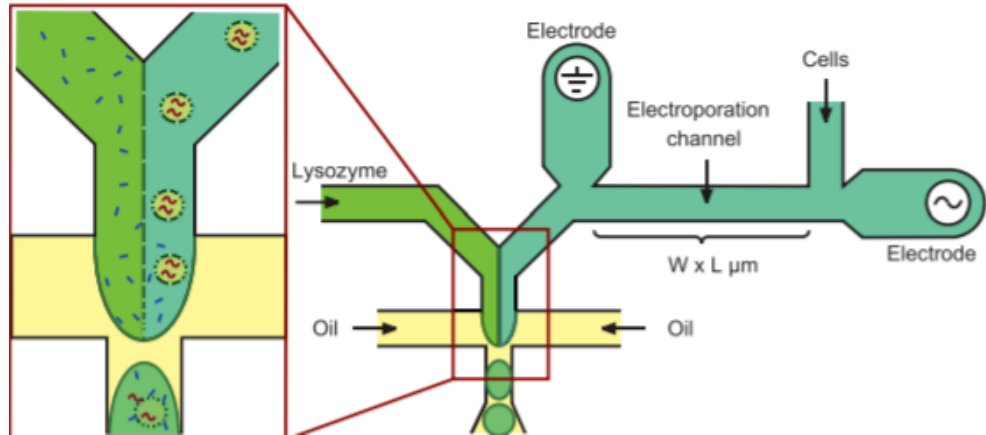
Figure 22. Schematic of the electrical lysis part and co-flow droplet generation part of the microfluidic device utilized in [74]. Adapted with permission from [74]. Copyright 2016 AIP Publishing.